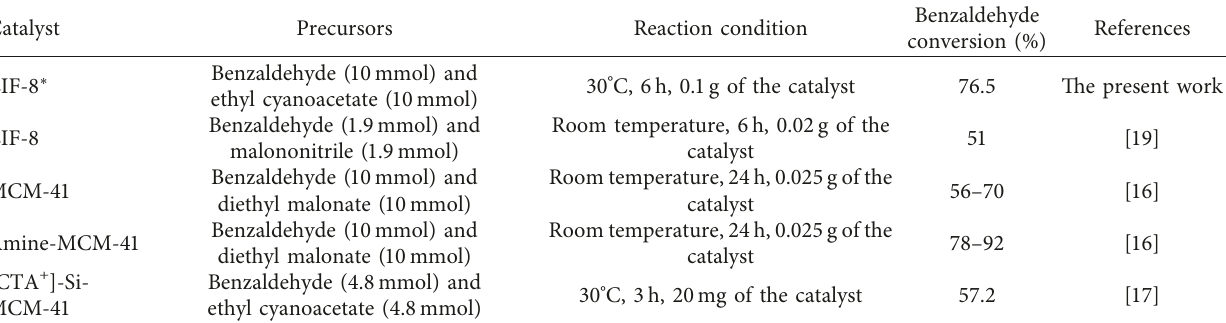
Figure 9: Effect of various ZIF-8 samples on the Knoevenagel condensation reaction: (a) benzaldehyde conversion (%); (b) ethyl-2-cyano-3- phenylacrylate selectivity ((1) without a catalyst; (2) Z-A(MeOH); (3) Z-B(DMF); (4) ZIF-8 sample synthesized with process A for five days; and (5) ZIF-8 sample synthesized with process B at 200 ° C). Table 3: Effect of the different catalysts on Knoevenagel